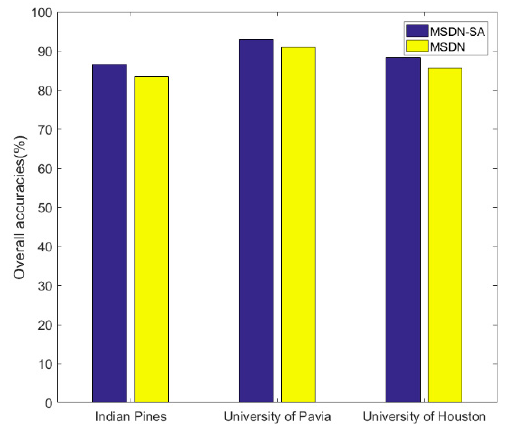
Figure 10. Effect of spectral-wise attention on: Indian Pines, University of Pavia and University of Houston